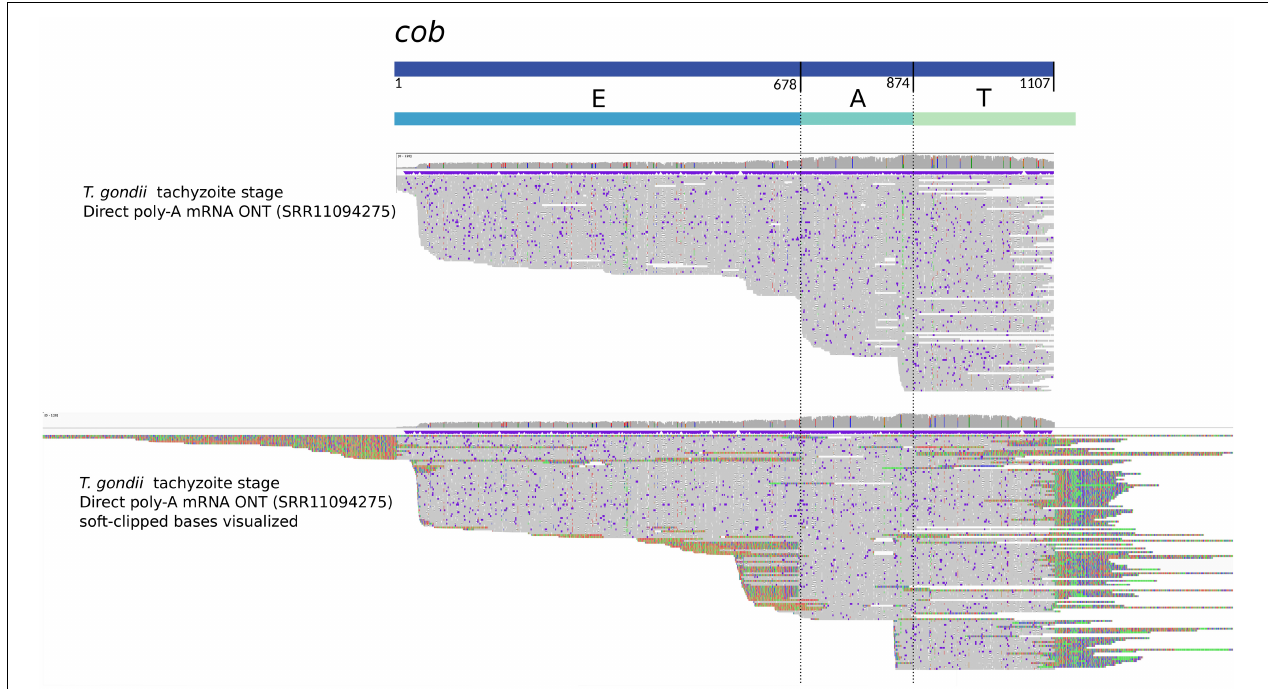
FIGURE 3 | Mapping of Oxford Nanopore mRNA reads with respect to the cob sequence in the mitogenome of T. gondii . The figure shows an adapted visualization obtained with IGV (Thorvaldsdóttir et al., 2013) of ONT direct RNA reads (Lee et al., 2021) aligned with minimap2 (Li, 2018) to the cob sequence inferred for T. gondii . Above, the rectangles represent the cob gene sequence and the proposed constituent sequence blocks “EAT” (Namasivayam et al., 2021), respectively. Vertical lines highlight the limits between E and A, and A and T blocks. In the alignment section, the upper part shows ONT reads aligned with hard clipping, and the bottom shows the same ONT reads with soft clipping visualization. Notoriously, there are reads covering the complete cob gene, but others align only to one (T) or two blocks (AT). In the case of the visualization with soft-clipping, the aligning part of the reads extend to sequence contexts not contiguous but otherwise present in other parts of the mitogenome. The latter correspond to other sequence